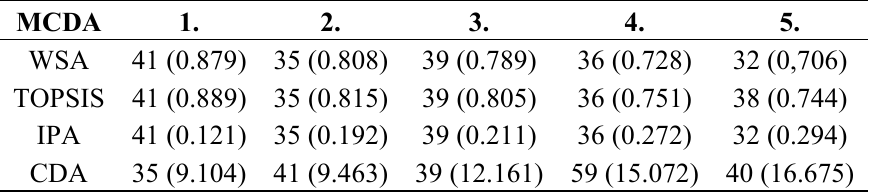
Table 7. Final MCDA scores for overall evaluation of external walls.